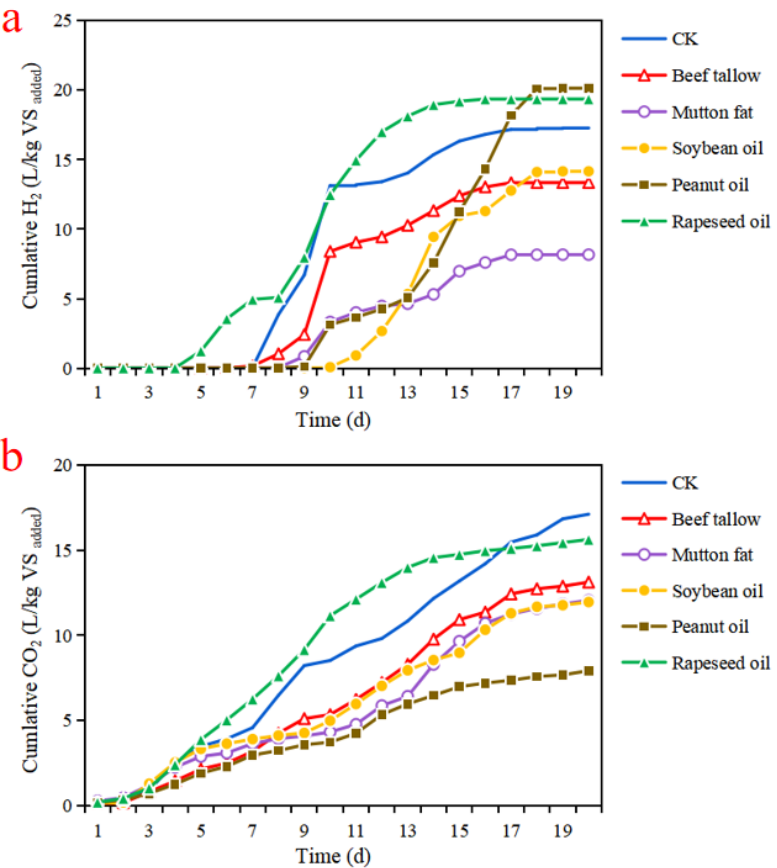
Figure 6. Cumulative acidogenic biogas production. ( a ) Hydrogen and ( b ) carbon dioxide in different treatments.